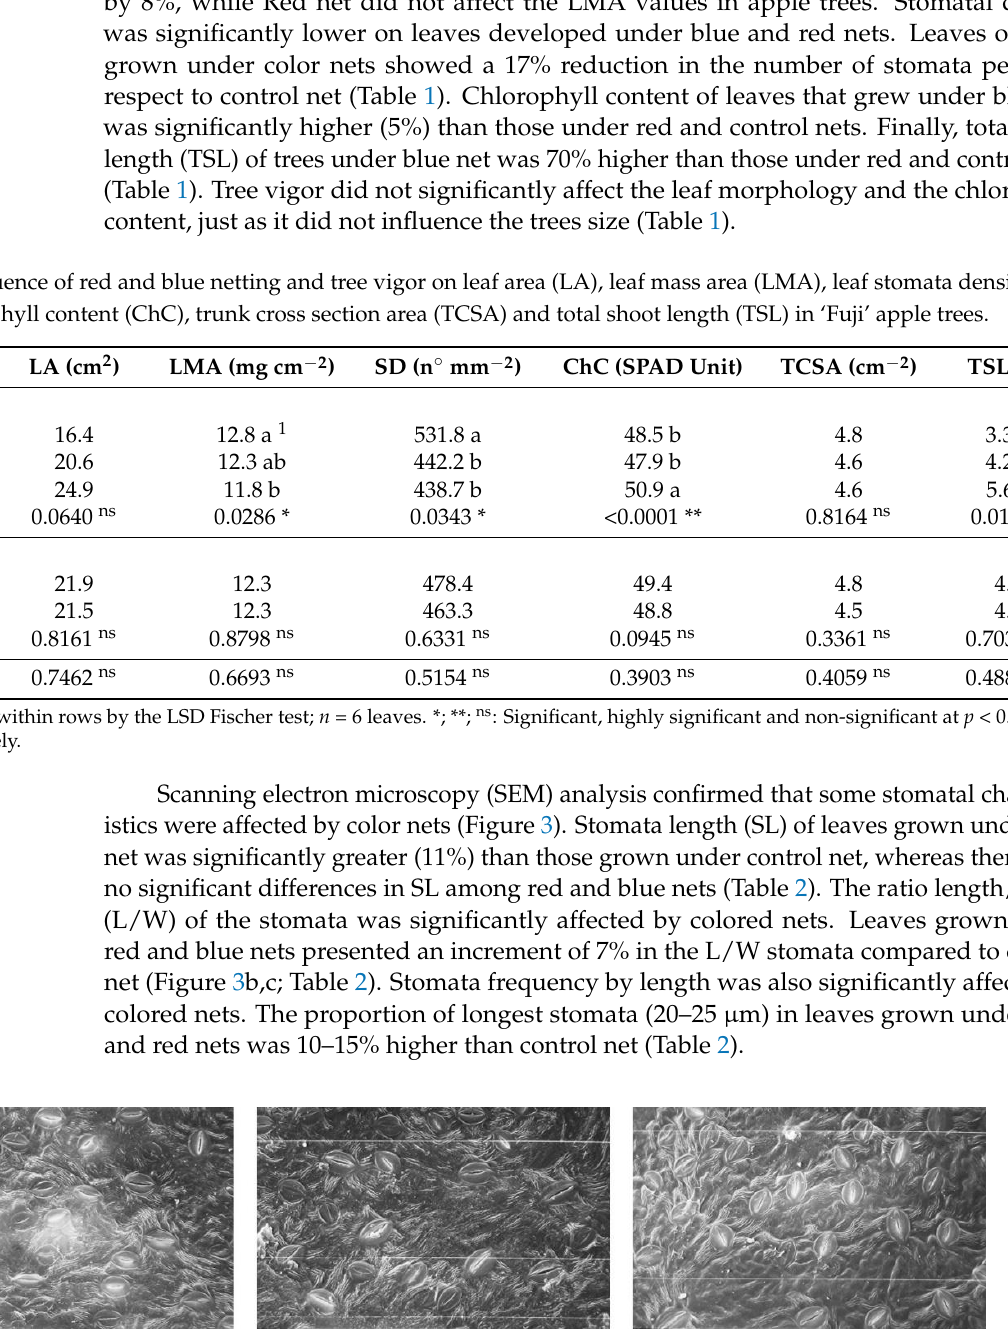
Figure 2. Spectral irradiance pattern measured in apple trees grown under blue, red and white control nets.